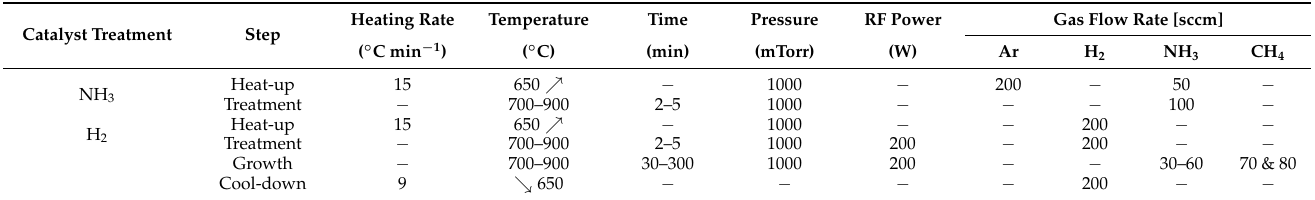
Table 1. Plasma-enhanced chemical vapor deposition (PECVD) process parameters of vertically- aligned carbon nanotubes (VA-CNTs) with detailed steps.